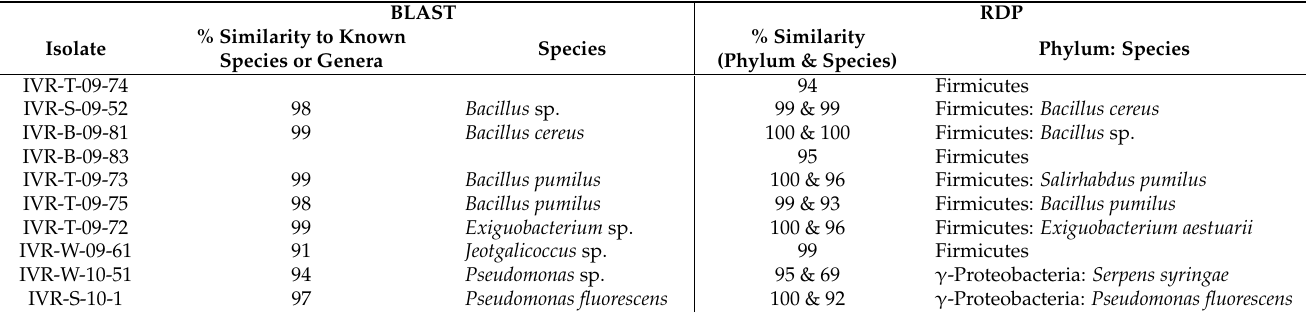
Table 3. Taxonomic assignments based on 16S rDNA sequencing of isolated cultured mesophilic bacteria from Isla Verde Reef (IVR) within the Veracruz Reef System. BLAST: Basic Local Alignment Tool; RDP: Ribosomal Database Project.